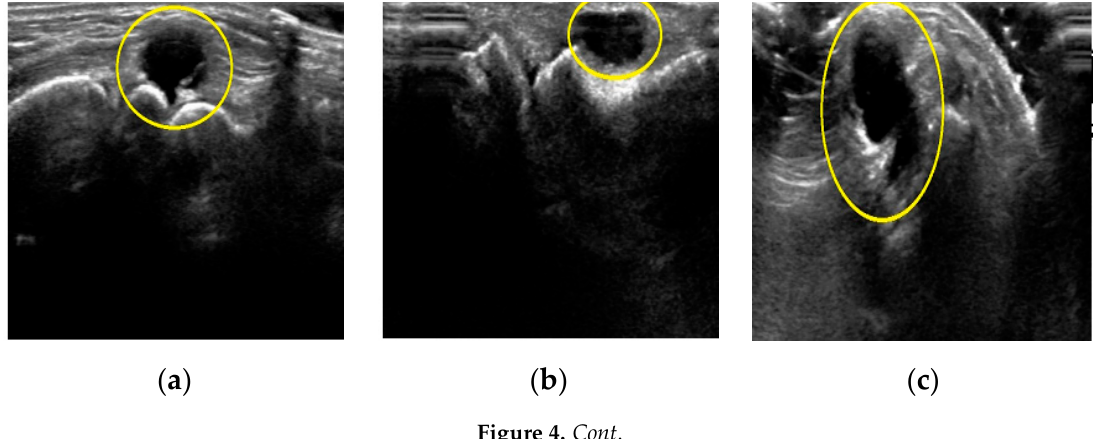
( f ) Figure 4. Cases of DBSCAN quantifications. ( a ) Input image 1; ( b ) input image 2; ( c ) input image 3; ( d ) #-of-clusters = 5; ( e ) dark cluster; ( f ) one cluster. 2.3. FCM as the Backend Segmentation Process FCM assigns the membership value of every pixel of an image based on the distance measure (Euclidean distance. m = 2 in this paper) to the centroid of each cluster. The clus- ter centroids and the corresponding membership values are iteratively updated as the members of the same cluster have more similarity. We apply FCM quantification process after DBSCAN and the FCM process in this paper can be summarized as shown in Algo- rithm 2. Algorithm 2 FCM quantification process. [Step 1] Initialize c (2 ≤ c < n ) for n pixels of the area as the result of (3) by DBSCAN quantization, and exponential weight m (1 ≤ m < ∞ ). Also initialize the error threshold ( ε ) for terminating condition and the membership degree U (0). [Step 2] Compute the centroid of a cluster as the mean of all points, weighted by their degree of belonging to the cluster as following, where i denotes the cluster number, j denotes the node number on input x of total n data. 𝑣 (cid:3036)(cid:3037) = (cid:3533)(𝑢 (cid:3036)(cid:3038) ) (cid:3040) 𝑥 (cid:3038)(cid:3037) / (cid:3533)(𝑢 (cid:3036)(cid:3038) ) (cid:3040)(cid:3041) (cid:3038)(cid:2880)(cid:2869)(cid:3041) (cid:3038)(cid:2880)(cid:2869) [Step 3] Then, compute the distance between the data point and each centroid point of the cluster as following where i denotes the number of nodes. 𝑑 (cid:3036)(cid:3038) = (cid:4686)(cid:3533)(cid:3435)𝑥 (cid:3038)(cid:3037) − 𝑣 (cid:3036)(cid:3037) (cid:3439) (cid:2870)(cid:3039) (cid:3037)(cid:2880)(cid:2869)